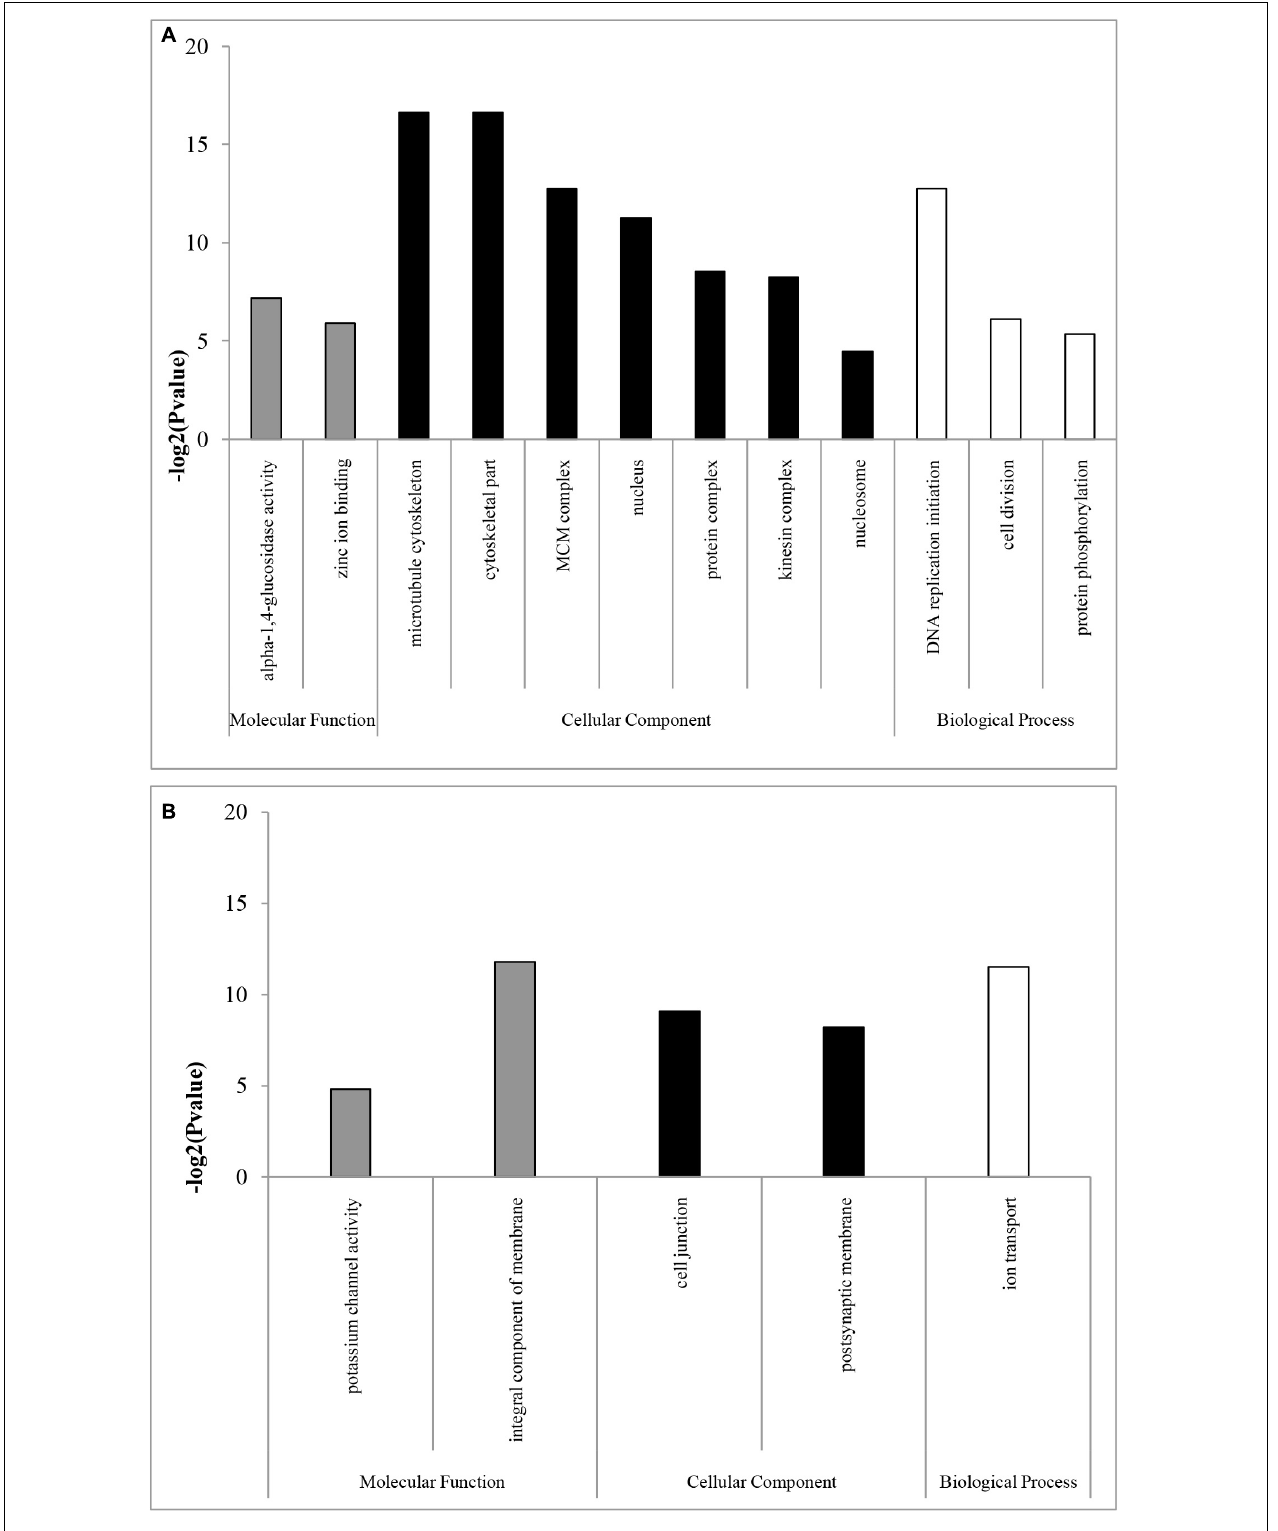
FIGURE 1 | GO enrichment analysis of (A) female- and (B) male-biased genes. GOSeq explicitly takes into account gene selection bias due to differences in gene length and thus the numbers of overlapping sequencing reads. GOSeq was used for the GO enrichment analysis, and an adjusted Q-value < 0.05 was chosen as the significance